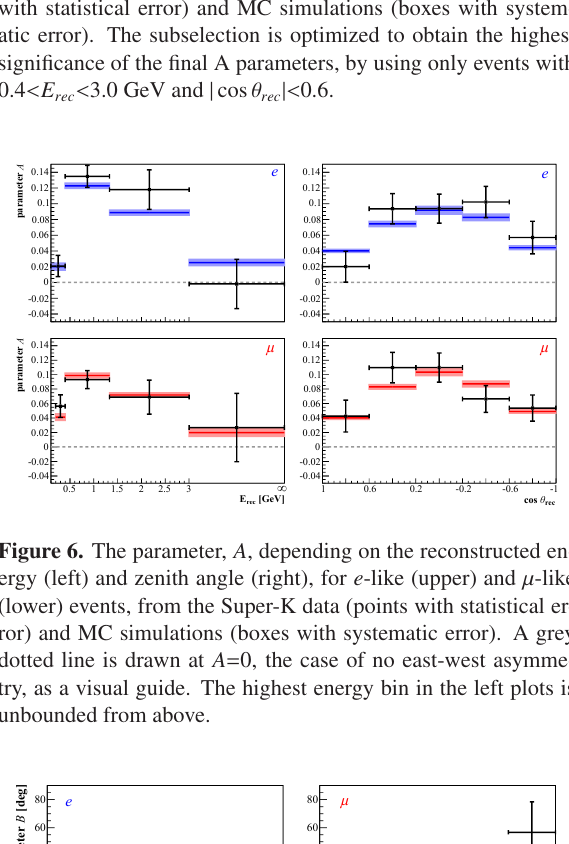
Figure 4. Measured energy spectra compared to the flux model predictions (dotted lines) from the HKKM11 (black), HKKM07 (light green), Bartol (red), and FLUKA (light blue) models. The vertical axis represents the flux ratio from the data (or each model) to HKKM11. Error bars include both statistical and sys- tematic uncertainties.